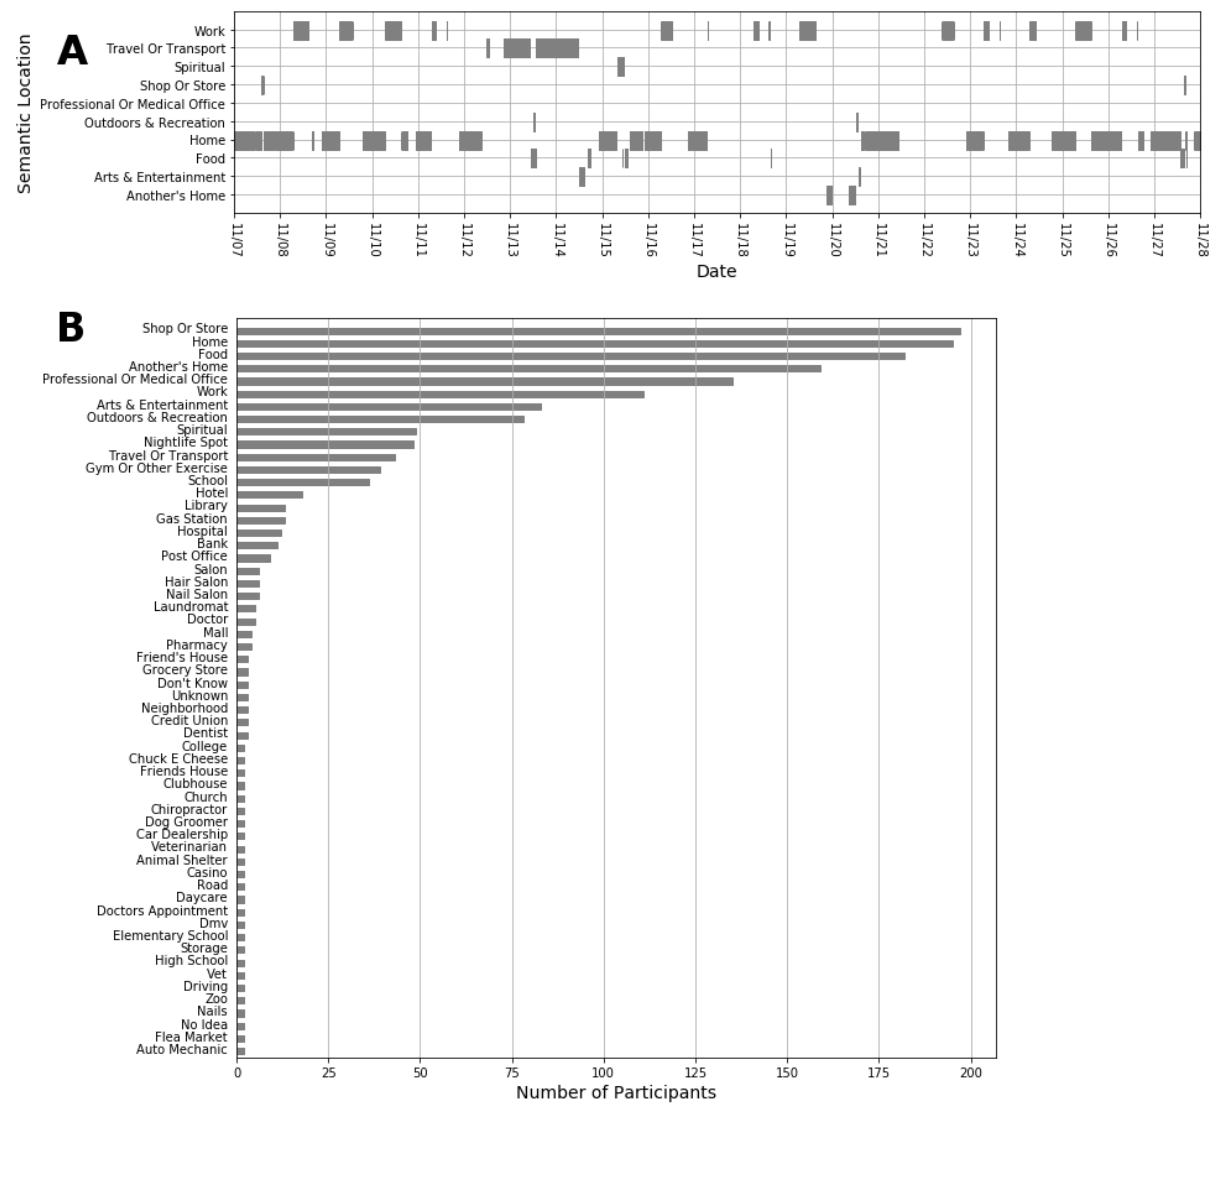
Figure 8. (A) Location report data from one example participant, collected between 11/07/2015 and 11/28/2015. Each rectangle shows the period of time the participant has been in a specific location. The sensor data during that time period is used to create a feature vector, which is then used to detect that semantic location. (B) Top locations visited by all participants, sorted by how many participants visited them. As the total number of unique reported locations was 370, we only included the ones that had been visited by at least two